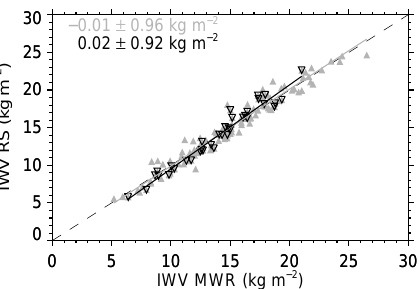
Figure 4. Comparison between IWV from MWR and RS during HOPE. Grey and black triangles indicate all weather conditions and only clear sky conditions, respectively. The solid lines notify the according regression lines. The numbers in the upper left corners denote the bias and the standard deviation,